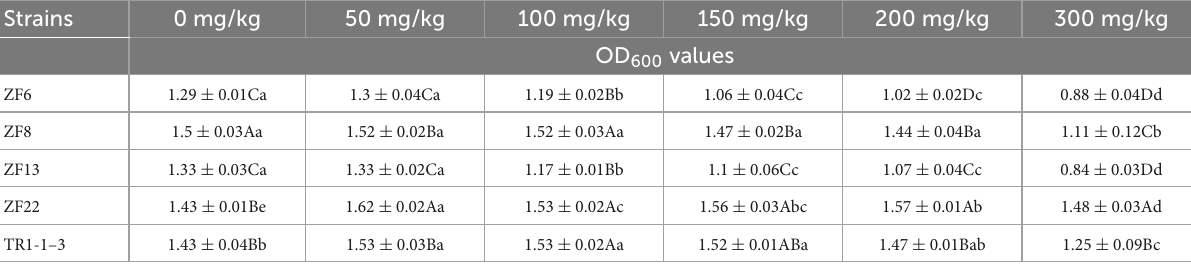
TABLE 3 Determination results of lactic acid bacteria tolerance to different NaNO 2 concentrations. Strains